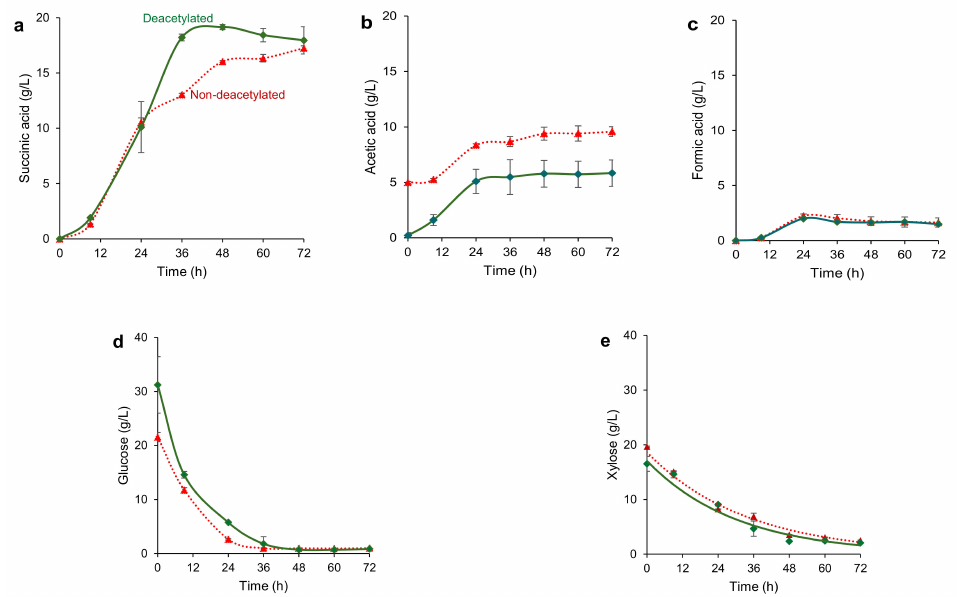
Figure 4. Time course of A. succinogenes fermentation for ( a ) succinic acid production, by-products ( b ) acetic acid, ( c ) formic acid formation, ( d ) glucose, and ( e ) xylose consumption from both deacety- lated (solid lines) and non-deacetylated (dashed lines) oil palm trunk